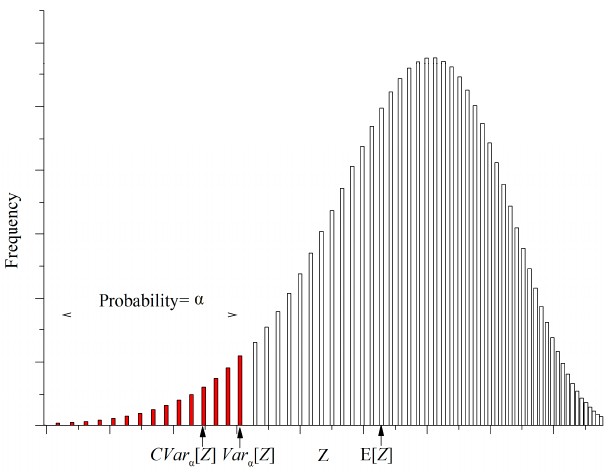
Figure 1. E [ Z ] , VaR α [ Z ] , and CVaR α [ Z ] of a benefit distribution Figure 1. ] Z Ε[ , [ ] VaR Z α , and [ ] CVaR Z α of a benefit distribution function.